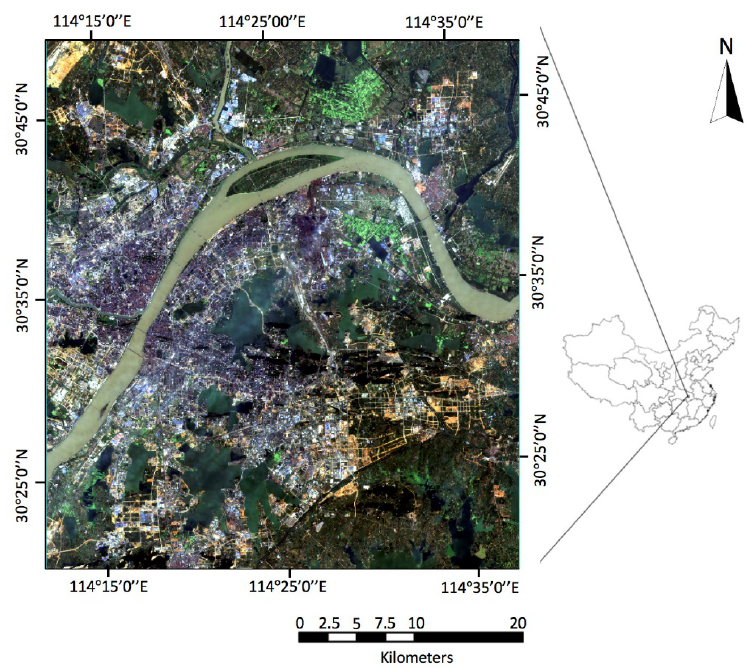
Figure 1. The study area represented by the Landsat 8 image (RGB) on 6 October 2014.